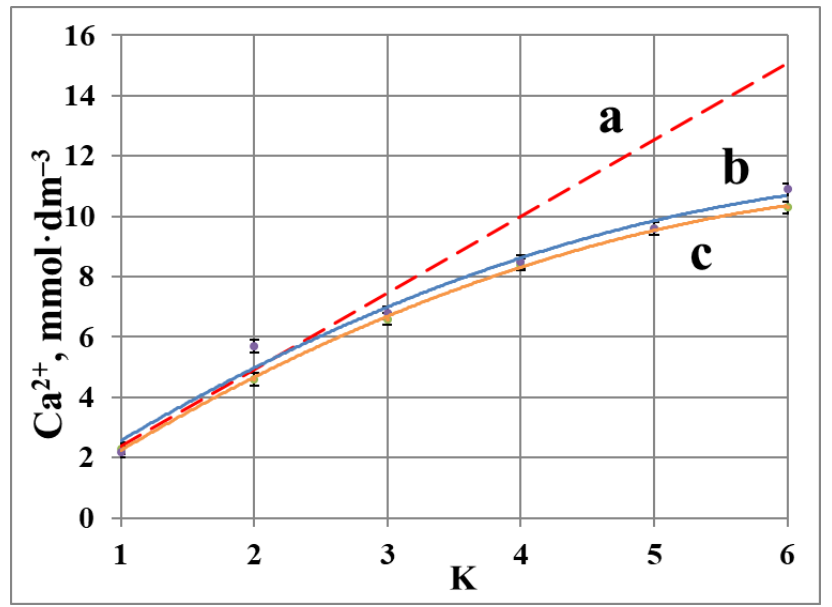
Figure 5. Variation of total calcium content in retentate + membrane ( a ); of calcium concentration in retentate in the presence of PAA-F1 ( b ); and in retentate in a blank run ( c ).